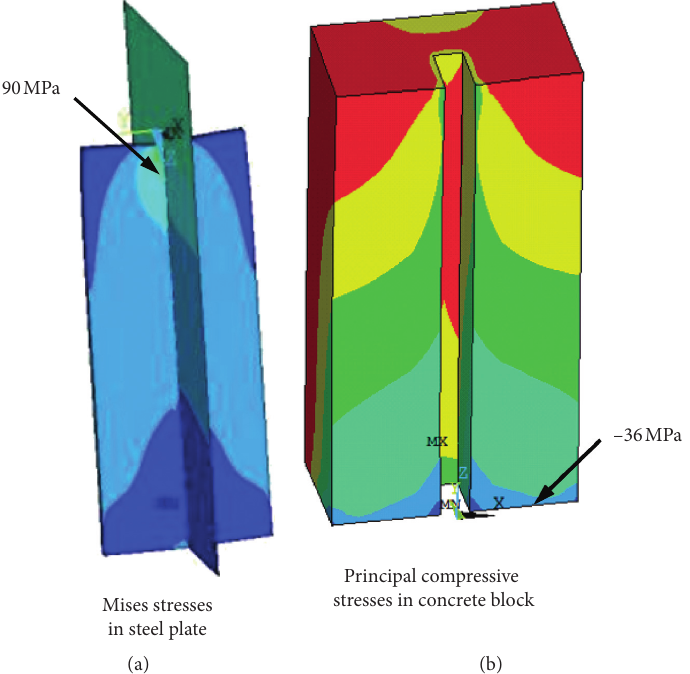
Figure 20: Maximum stresses in steel plate and concrete block.